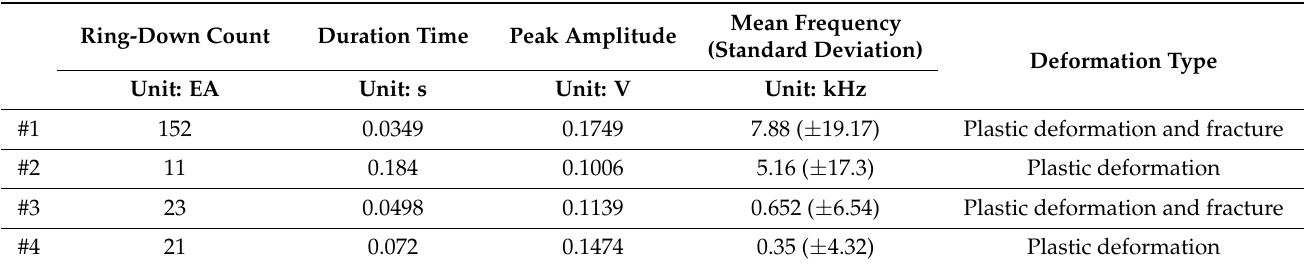
Figure 11. Result of fast Fourier transform applied to AE filtered signal.